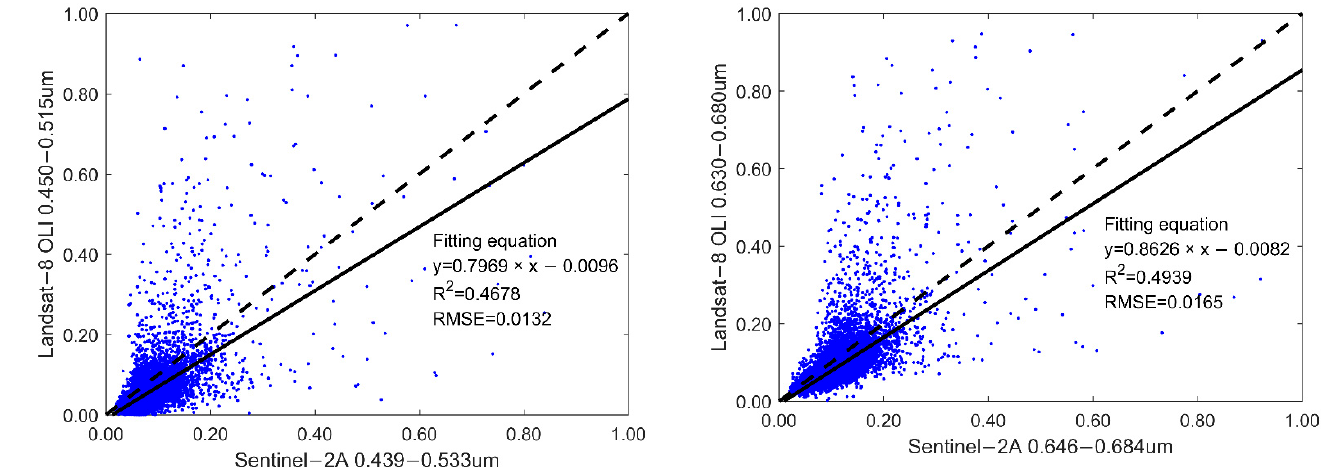
Figure 13. Using all pixels of two images to fit scatter plots.